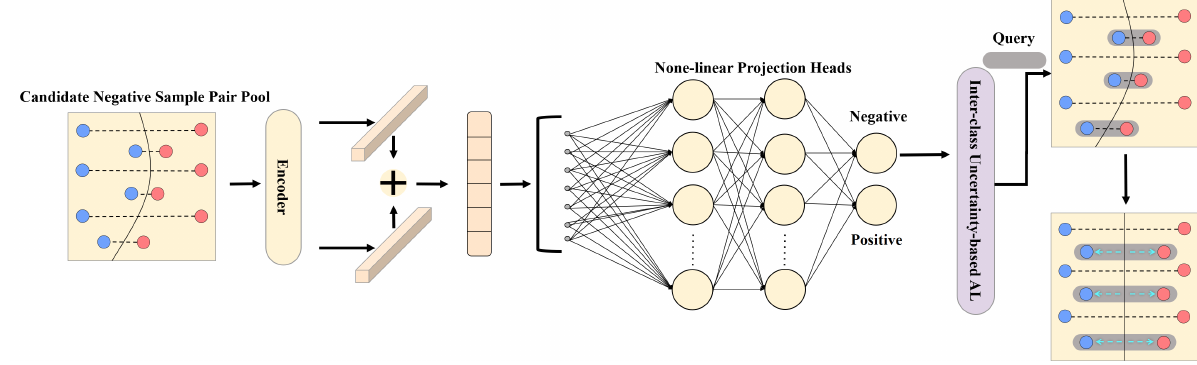
Figure 3. Graphical illustration of inter-class uncertainty-based active learning (ICUAL). Synthesizing the above methods, the pseudo code of the ALSN algorithm can be seen in Algorithm